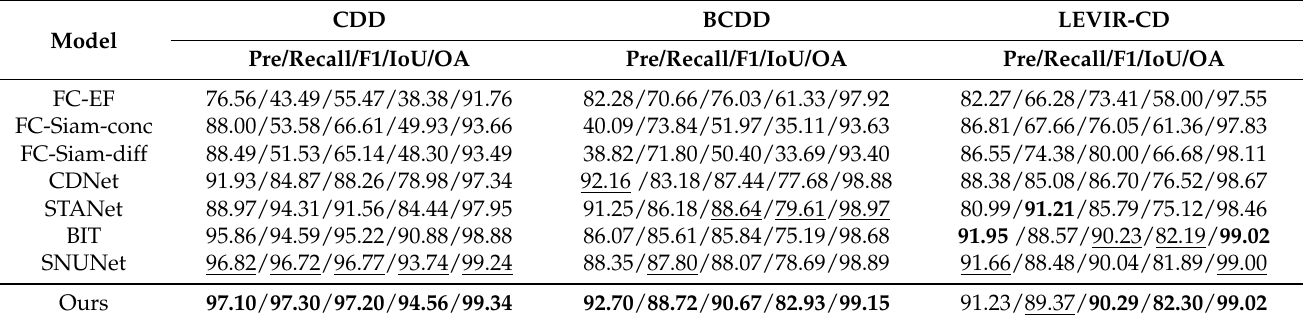
Table 4. Quantitative results on the three dataset. The best two results are in bold and underline. All scores are expressed as a percentage